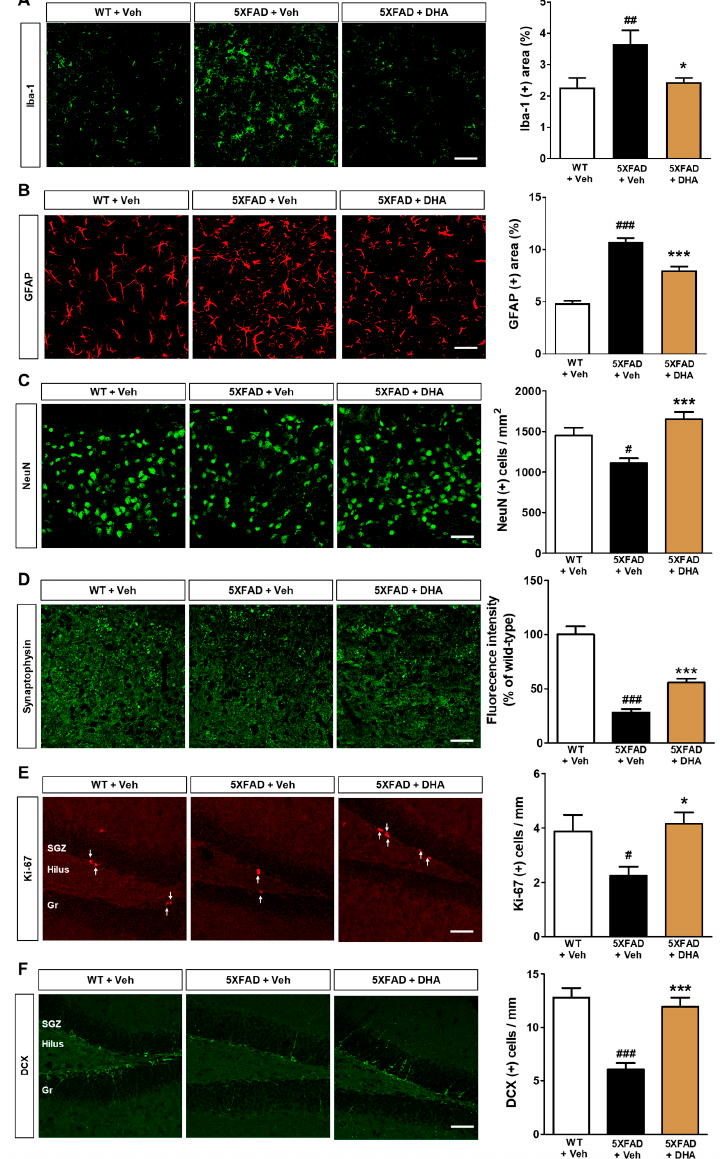
Figure 6. Effects of DHA on AD-related pathogenesis in the 5XFAD mice. ( A – D ) Immunofluorescence staining was performed for evaluation of neuroinflammation and neuronal loss with markers of microglia (Iba-1), astrocytes (GFAP), neurons (NeuN), and presynaptic vesicles (SYN) in the dorsal subiculum. ( A , B ) The percentage of Iba-1 ( + ) and GFAP ( + ) area coverage significantly increased in 5XFAD mice compared to WT mice, but this was significantly alleviated by DHA administration. ( C ) The significant reduction in the number of NeuN ( + ) cells per area in the dorsal subiculum observed in 5XFAD mice was significantly alleviated by DHA administration. ( D ) The fluorescence intensity of SYN in the dorsal subiculum was normalized to that observed in vehicle-treated WT mice. The reduced SYN fluorescence intensity in 5XFAD mice was significantly relieved by DHA administration. ( E , F ) Immunofluorescence staining was performed for the evaluation of adult hippocampal neurogenesis with the proliferating cell marker Ki-67 and the neuronal precursor marker DCX in the SGZ of the DG. A significant reduction in the numberofKi-67( + )andDCX( + )cellsperlengthofSGZwasobservedin5XFADmice, andwassignificantly alleviated by DHA administration. All histological qualitative data are presented as mean ± SEM (scale bar = 50 µ m, 42 images / seven mice). # p < 0.05, ## p < 0.01, and ### p < 0.001: vehicle-administered WT mice versus vehicle-treated 5XFAD mice. * p < 0.05 and *** p < 0.001: vehicle-treated 5XFAD mice vs. DHA-treated 5XFAD mice. Gr: granular layer, Mo: molecular layer, SGZ: subgranular